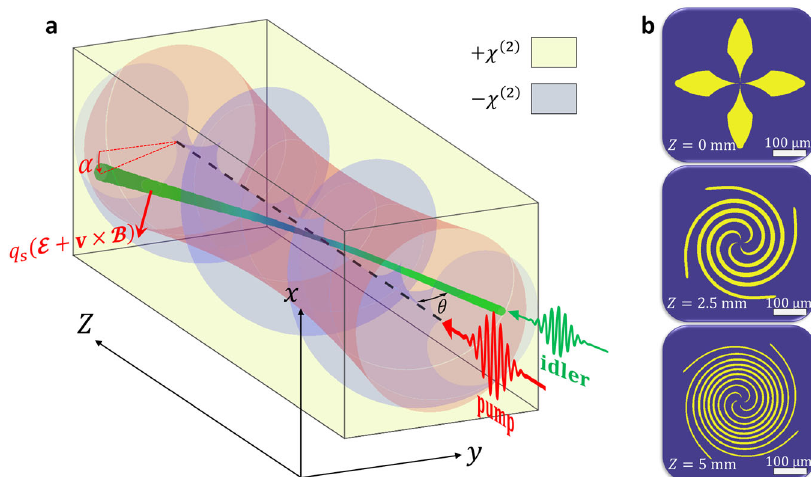
(cid:4) (cid:5) nonlinear photonic crystal with an imprinted synthetic skyrmion texture (gray and Fig. 2 Topological Hall effect for light beams. a A quadratic χ 2 ð Þ yellow for negative and positive nonlinearity poling) is illuminated by a broad pump beam (red). A tightly focused beam in the idler frequency (green) impinges the crystal at an angle θ with respect to the optical axis (dashed black line). As the beam propagates, it experiences adiabatic frequency conversion to the signal frequency (blue) and back to the idler frequency, as the spectral pseudospin adiabatically follows the local direction of the effective skyrmionic magnetization (see also Fig. 1d). As a result, a real-space geometric phase is accumulated, and the synthetic gauge fi elds associated with it give rise to an emergent Lorentz force, causing the beam waist to de fl ect by an angle α in the transverse plane (shifting the x -axis position of the beam at the output). b cross sections of a high-order skyrmionic nonlinear photonic crystal used in Fig. 3c,d, at crystal center ð Z ¼ 0 Þ , Z ¼ 2 : 5mm, and Z ¼ 5mm. The nominal quasi-phase-matching period is 10 : 24 μ m, and it changes between 10 : 33 μ m at the crystal center (the optical axis), to 10 : 15 μ m at the